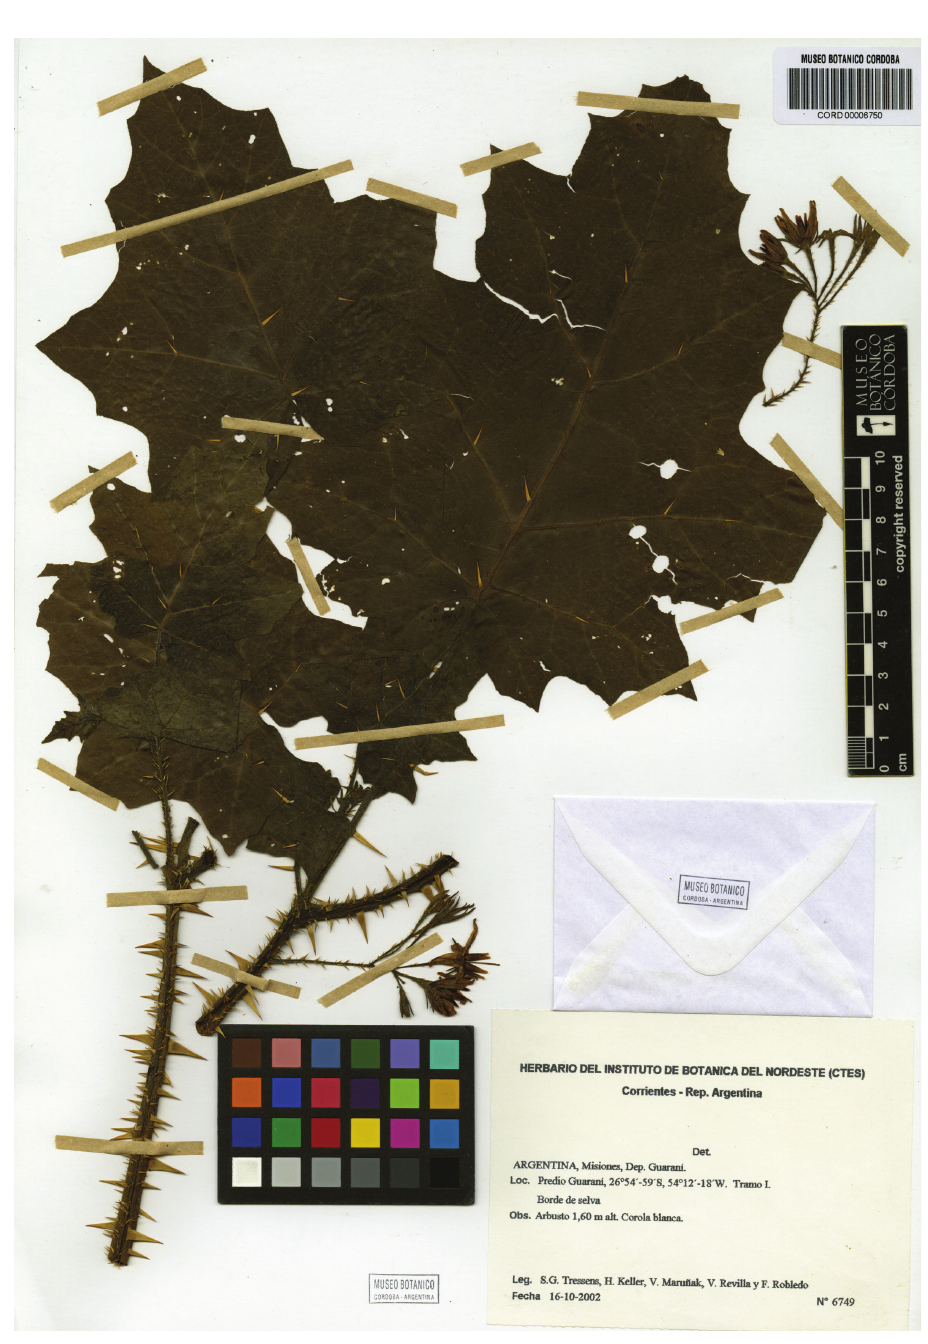
Figure 3. Photograph of the holotype of Solanum neei ( Tressens et al. 6749 , CORD 00006750)